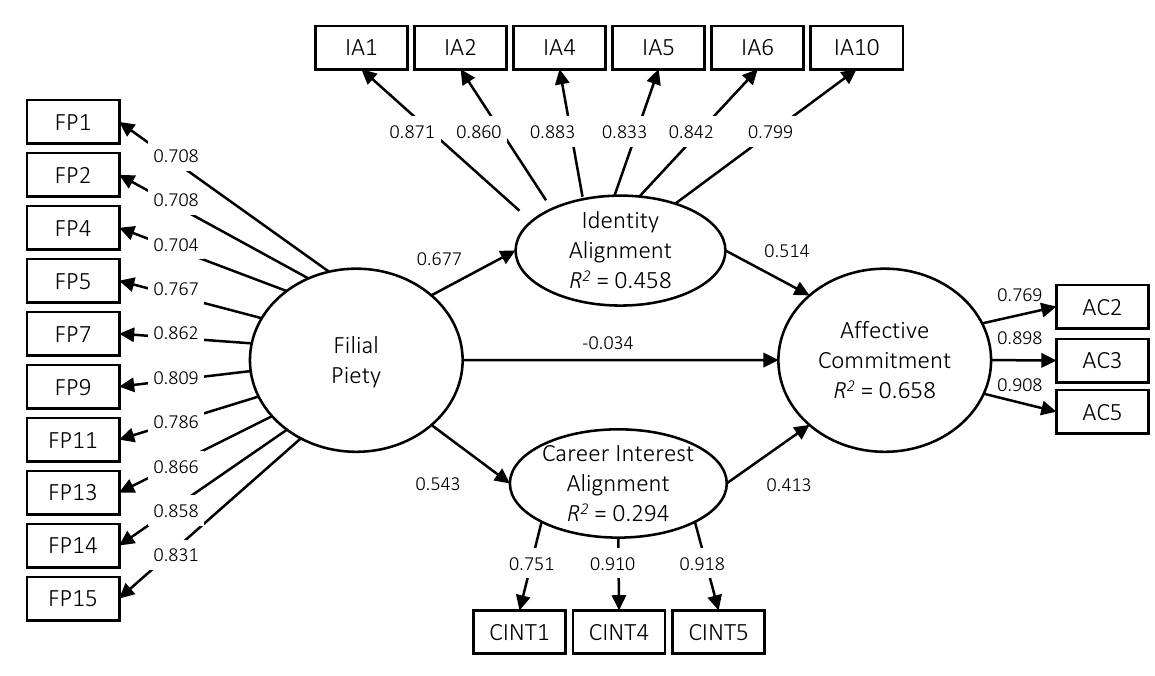
Figure 2. Final PLS-SEM model